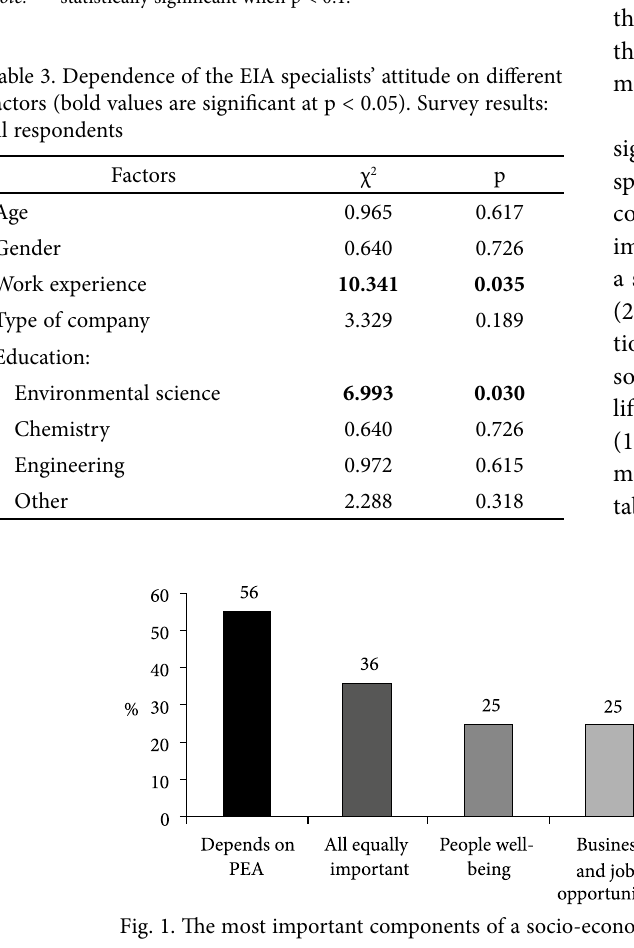
Note: * – statistically significant when p <